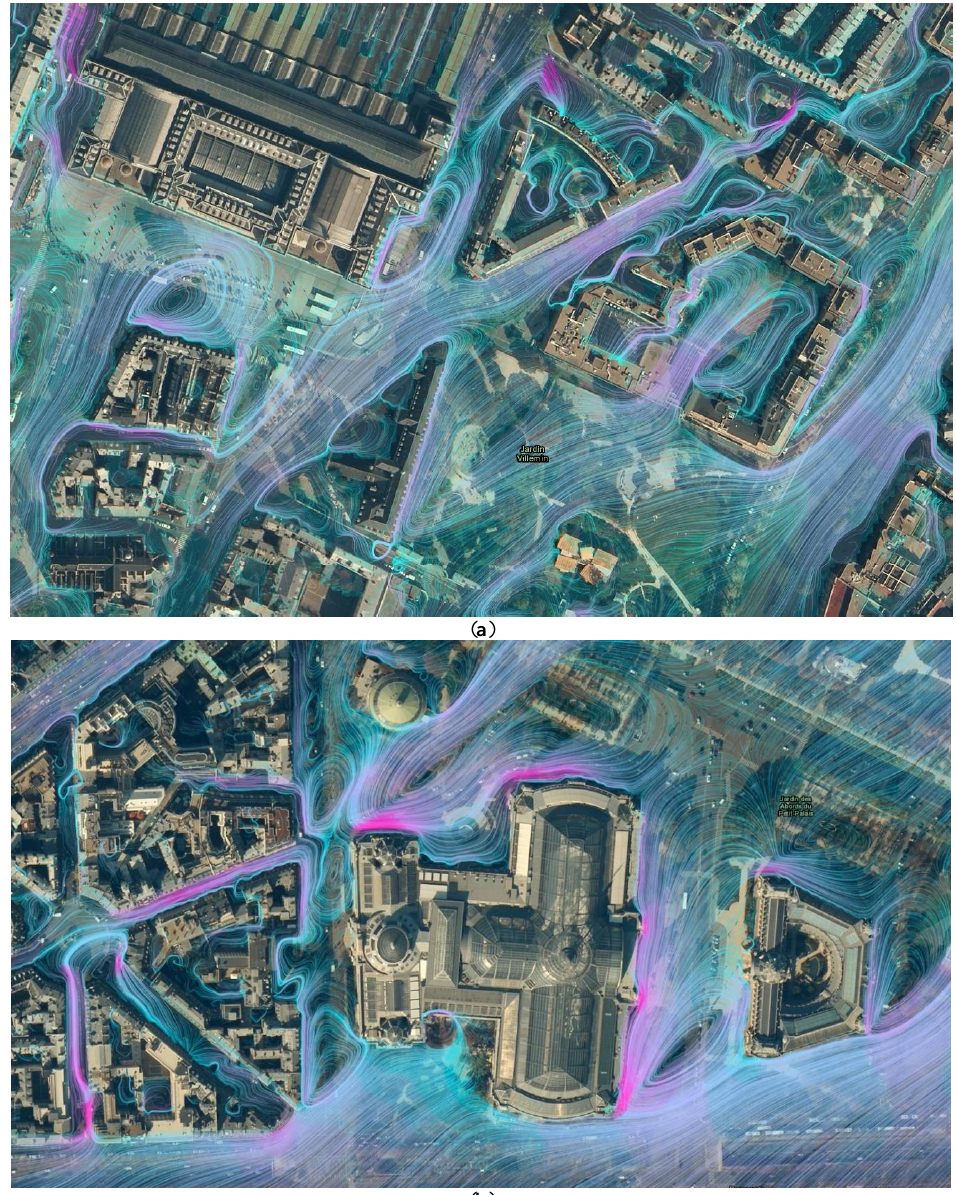
Figure 5. Closeup view of the flow streamlines computed in the streets near ( a ) the train station and ( b ) the museum. North is at the top.